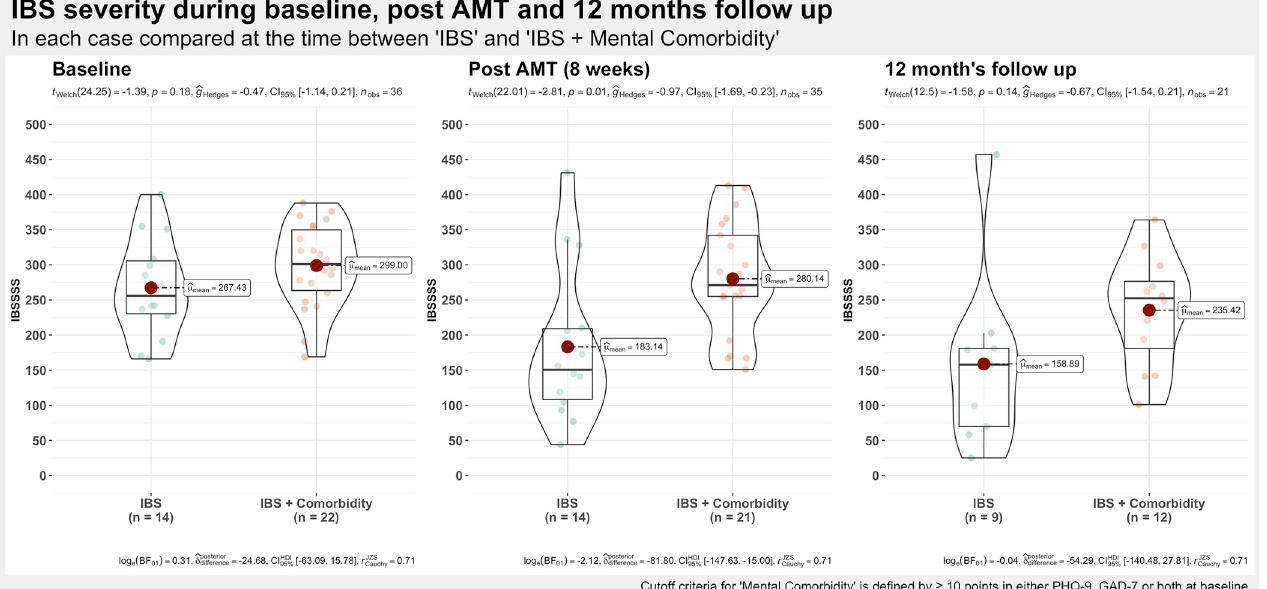
PLOS ONE | https://doi.org/10.1371/journal.pone.0277880 November21,